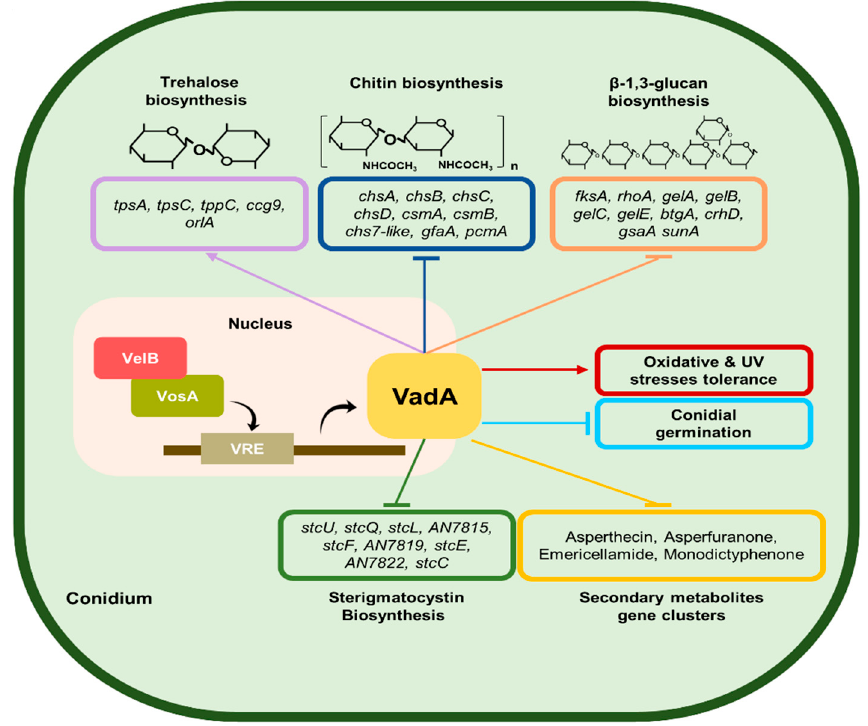
Figure 7. Genetic model for VadA-mediated regulation in A. nidulans conidia. A proposed model for the VadA-mediated conidiogenesis is presented. Figure S1: Heat map showing the clustering of the di ff erentially expressed genes (DEGs) between control and ∆ vadA conidia (fold change > 2.0 and q-value < 0.05) is presented. Figure S2: Functional enrichment analysis